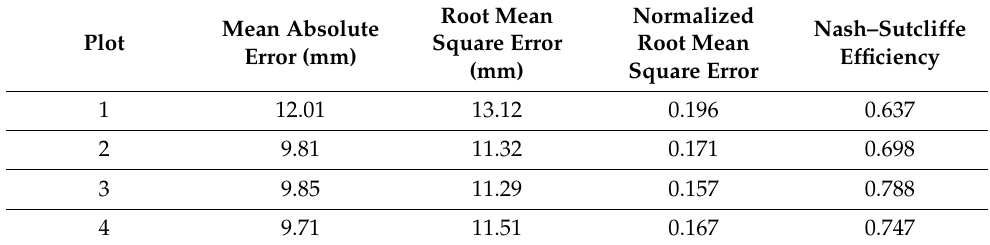
Table 6. Summary of the statistics obtained during model validation.